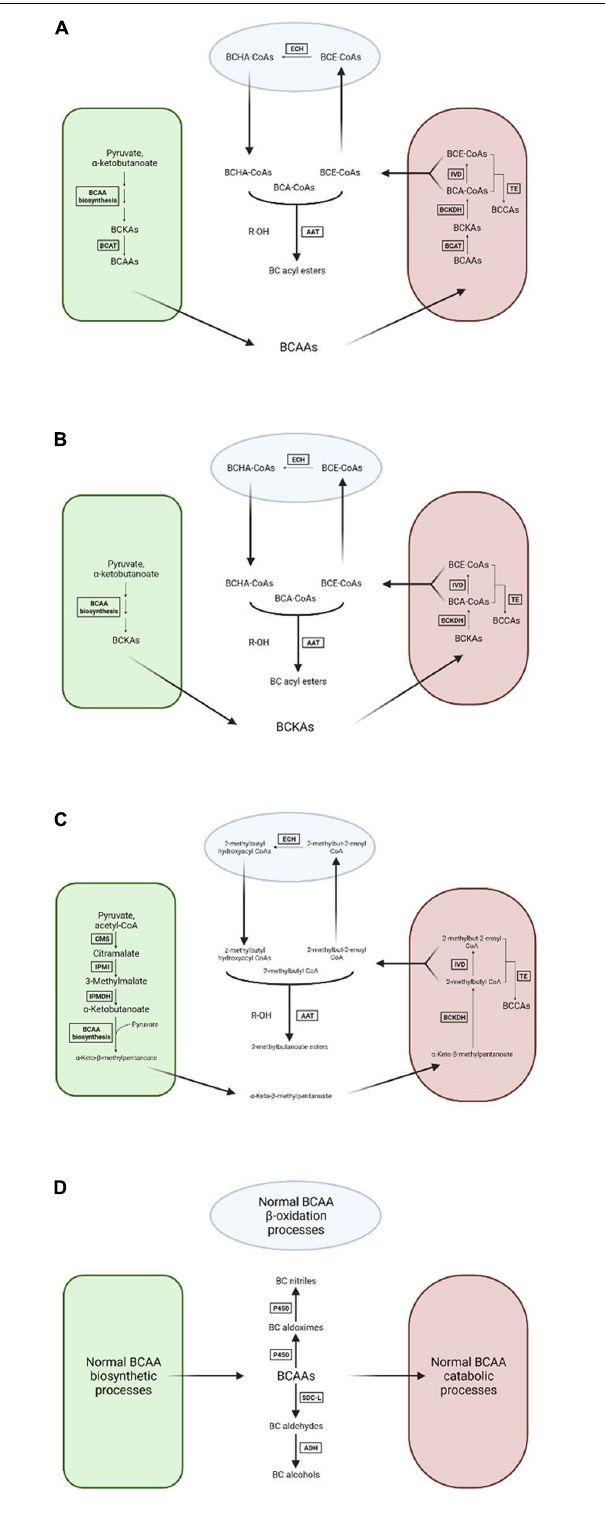
FIGURE 2 | Visual diagrams of the four hypotheses concerning branched-chain volatile biosynthesis in plant cells. (A)